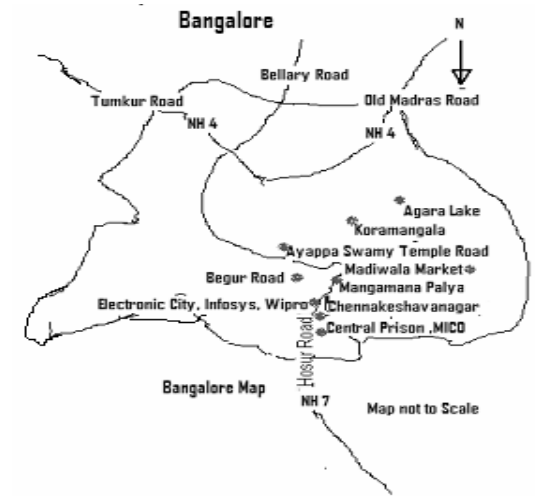
Figure 1 . Study stations of Hosur Road